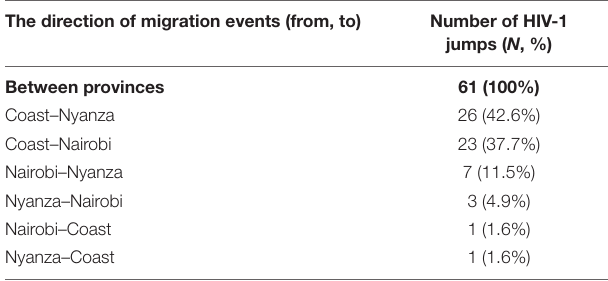
TABLE 5 | The number of expected (Markov) jumps inferred for HIV-1 A1 migration between geographic locations. The direction of migration events (from,